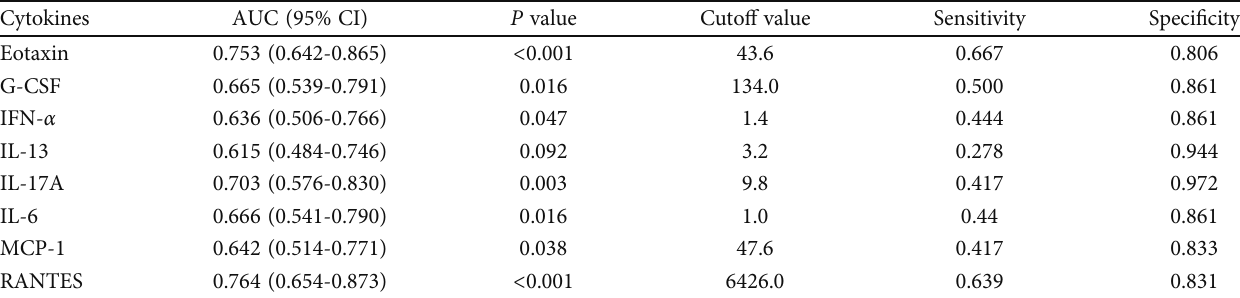
ROC: receiver-operating characteristic; CRSwNP: chronic rhinosinusitis with nasal polyps; AUC: area under the curve; CI: con fi dence interval; G-CSF: granulocyte colony-stimulating factor; IFN- α : interferon alpha; IL: interleukin; MCP: monocyte chemotactic protein; RANTES: regulated upon activation normally T expressed and presumably